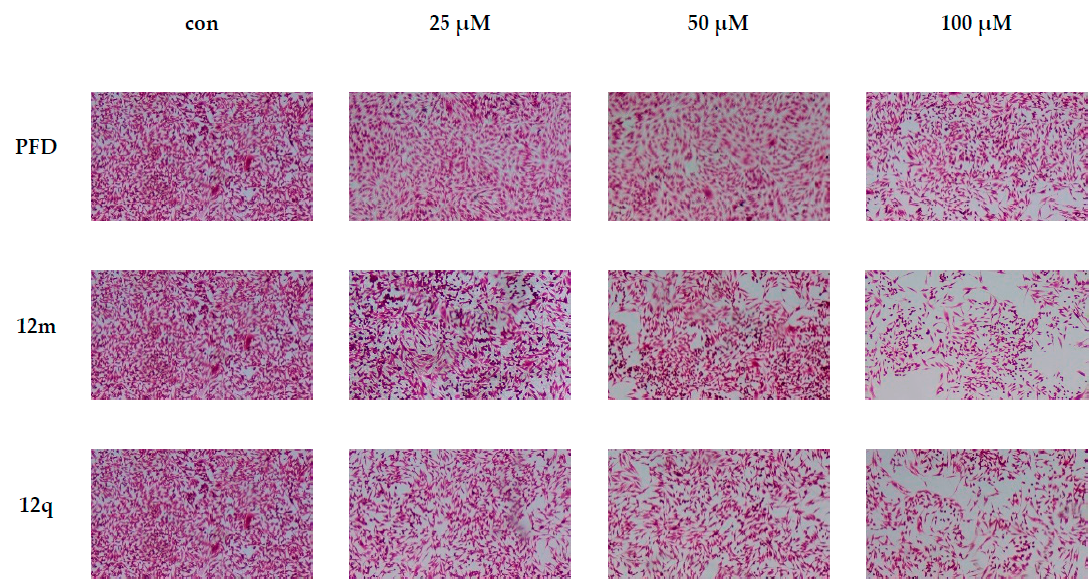
Figure 3. Picro-Sirius red (PSR) staining for total collagen accumulation in HSC-T6 cells.